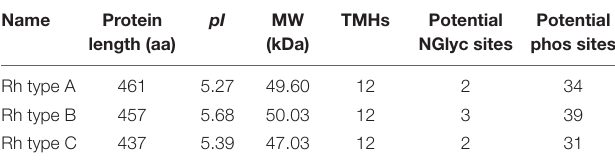
TABLE 3 | Characteristics of Rh sequences of M. manhattensis